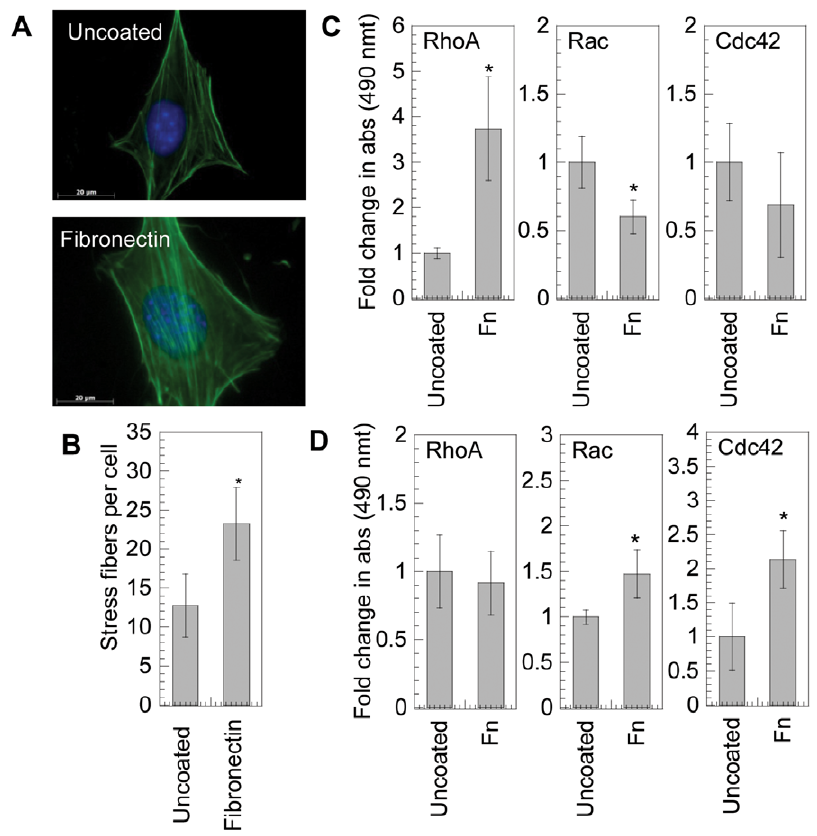
Figure 1. RhoGTPase activation on fibronectin. ( A ) mMSCs were plated on uncoated or fibronectin (40 m g/mL) coated surfaces for 16 hours and cell morphology was studied by staining cells for actin using Alexa488 conjugated phalloidin (green), and for DNA using Hoechst 33258 dye (blue). Images were taken with a Zeiss AxioObserver Z1 inverted microscope at 100 6 magnification. ( B ) Stress fiber quantification. ( C and D ) Active RhoGTPase quantification was performed using GLISA specific for RhoA, Rac1,2,3 and Cdc42. Cells were culture in PDMS sheets and allowed to attach and spread before exposing them to protein modified plastic for 20 minutes or 1 hour. The average of three samples was plotted. The level of active RhoGTPase in samples exposed to fibronectin was compared with untreated sample using the unpaired t-test (two tail p value). The symbols * represents a significant change to the level of p , 0.05. The error bars represent the standard deviation in all plots.